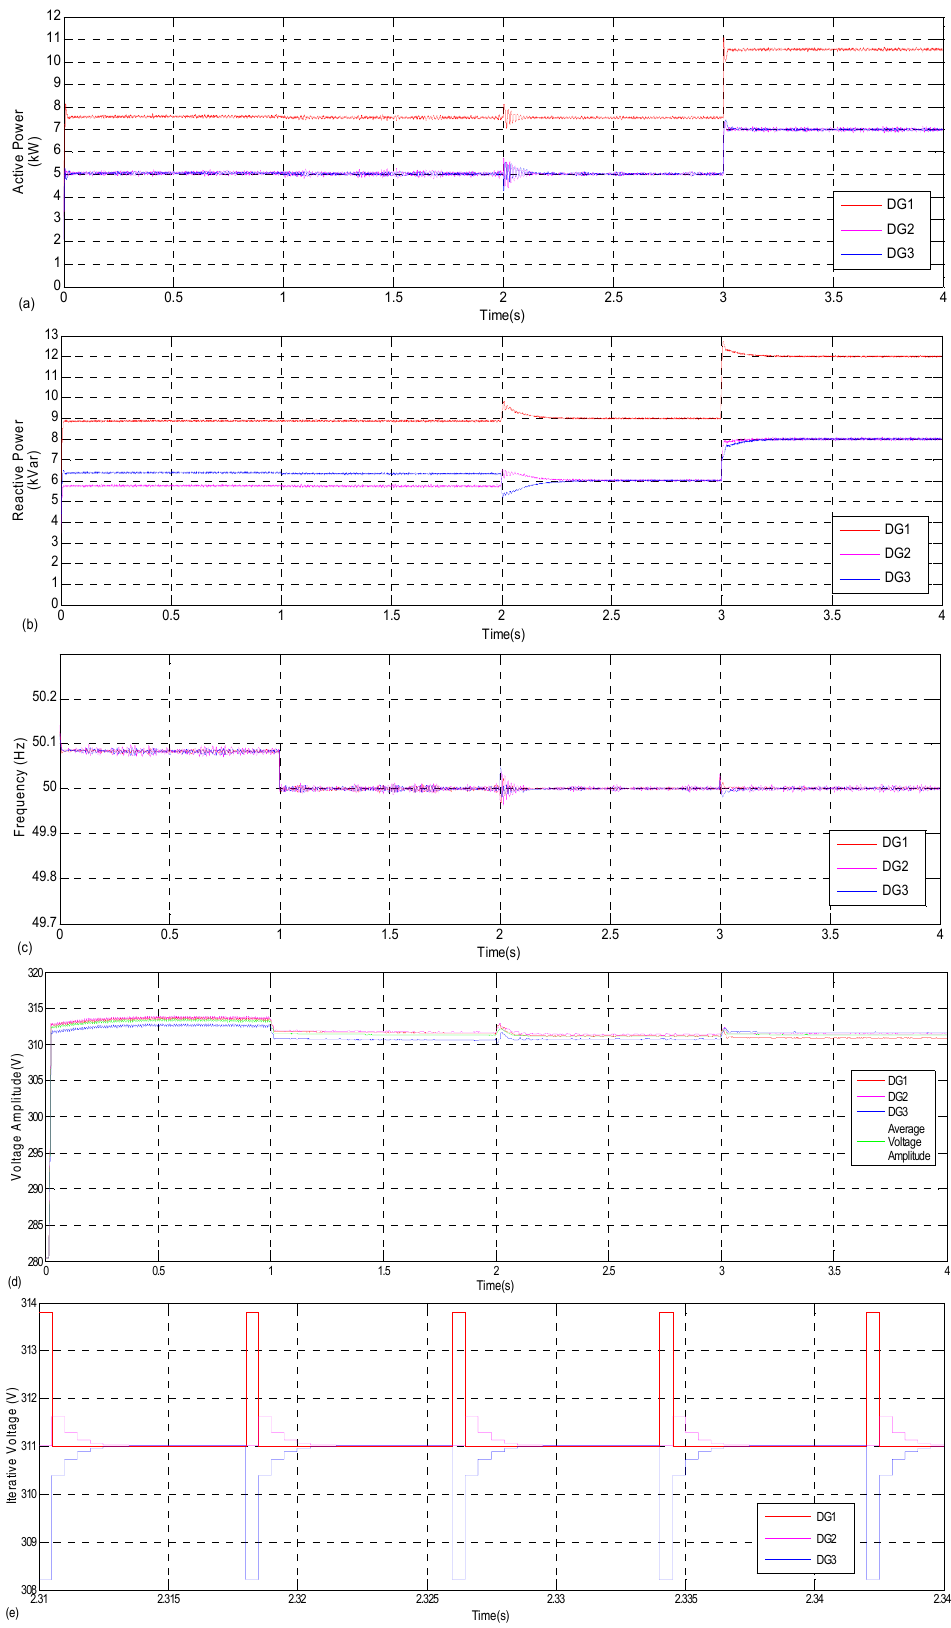
Figure 8. Simulation results in Case A: ( a ) active power; ( b ) reactive power; ( c ) frequency; ( d ) output voltage amplitude and average voltage amplitude; and ( e ) iterative voltage amplitude.